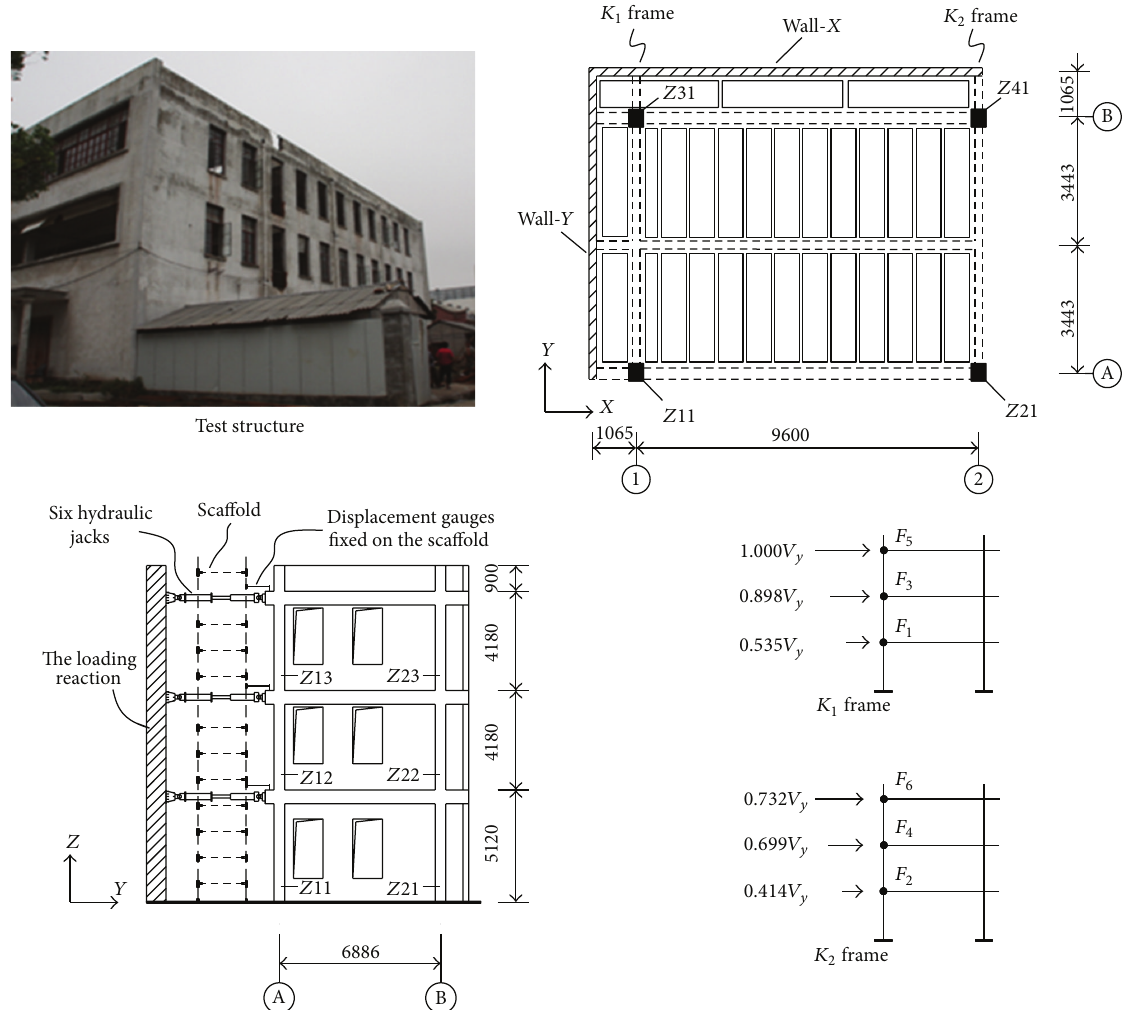
Figure 6: The test structure and loading method (unit: × 10 −3